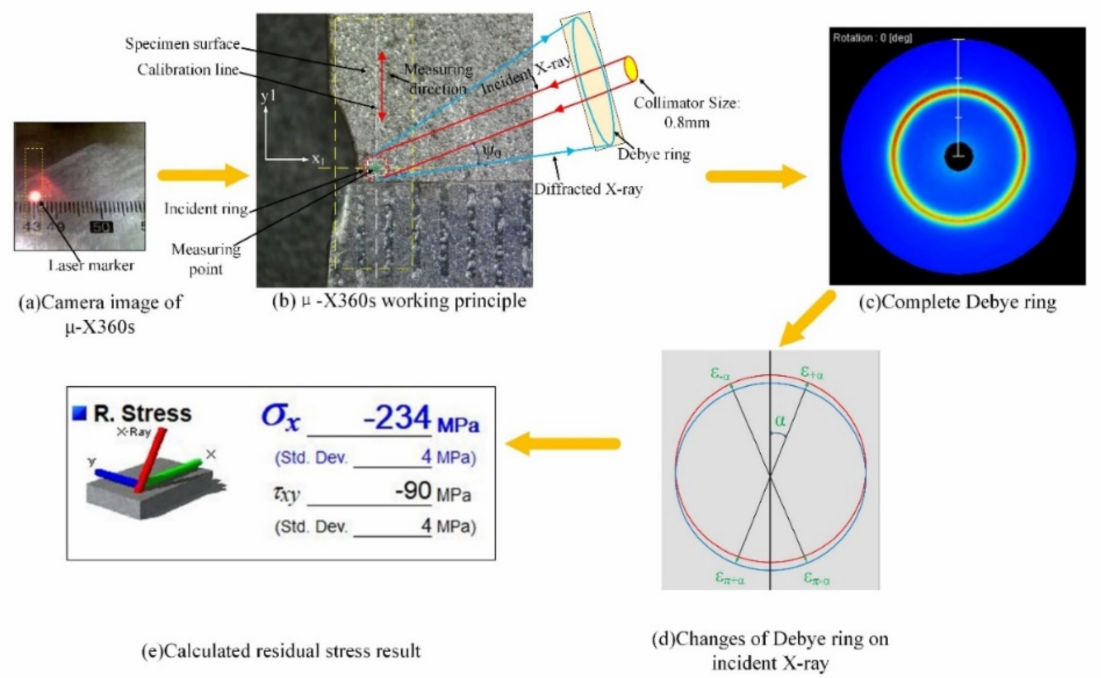
Figure 9. The schematic diagram of measuring principle of µ –X360s: ( a )the camera image of µ –X360s, ( b ) the working principle, ( c ) the detected Debye ring, ( d ) the changes of Debye ring, and ( e ) the calculated residual stress